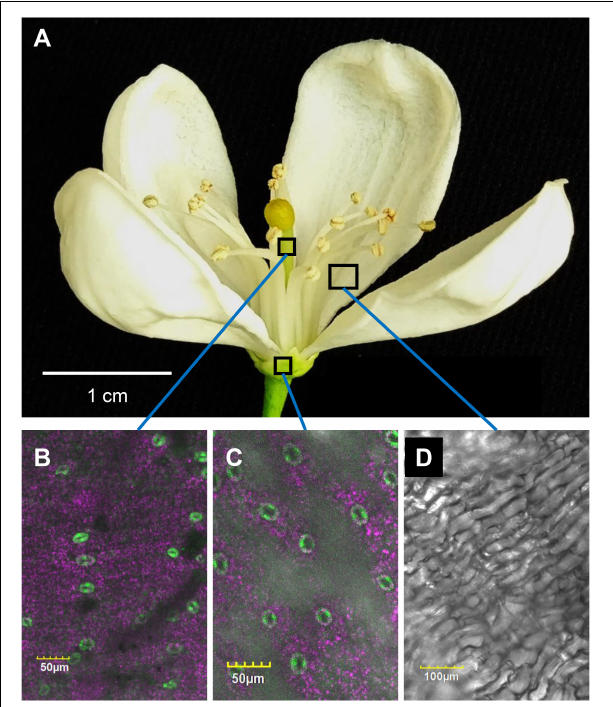
FIGURE 2 | Temporal and spatial distribution of the stomata on a citrus ovary. The confocal images C , E , and F are merged images of white light, chlorophyll autofluorescence (stained magenta), and GFP fluorescence (stained green). Samples were taken from GCGFP plants. The images in the lower row were taken from flowers 3 days older than the images shown in the upper row. (A) A closed GCGFP flower. (B) Binocular image of a dissected closed flower, revealing the ovary. (C) Confocal image of an ovary from a closed flower. (D) An open GCGFP flower. (E) Confocal image of the proximal part of an ovary from an open flower. (F) Confocal image of the distal part of an ovary from an open flower. Analyses were performed on five biological replicates.